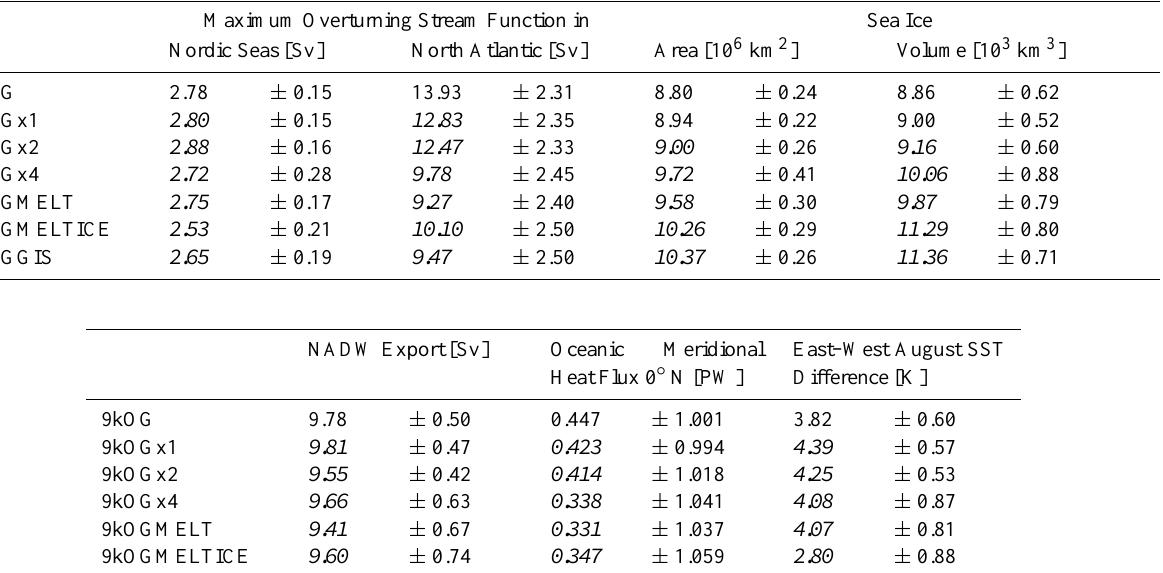
Table 2. Summary of key variables from all snapshot simulations. Mean and standard deviation of the (1) maximum meridional overturning stream function in the Nordic Seas and the North Atlantic at 27 ◦ N, (2) sea ice area and volume in the Northern Hemisphere, (3) North Atlantic Deep Water exported south at 20 ◦ S, (4) meridional heat flux in the Atlantic ocean at the equator and (5) Nordic Seas east–west August SST difference. Values are calculated from the last 100yr of each